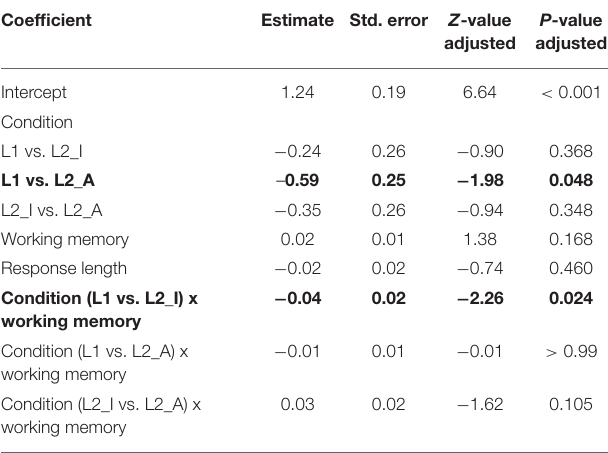
TABLE 5 | Beta regression model output for recall of participants’ own speech.